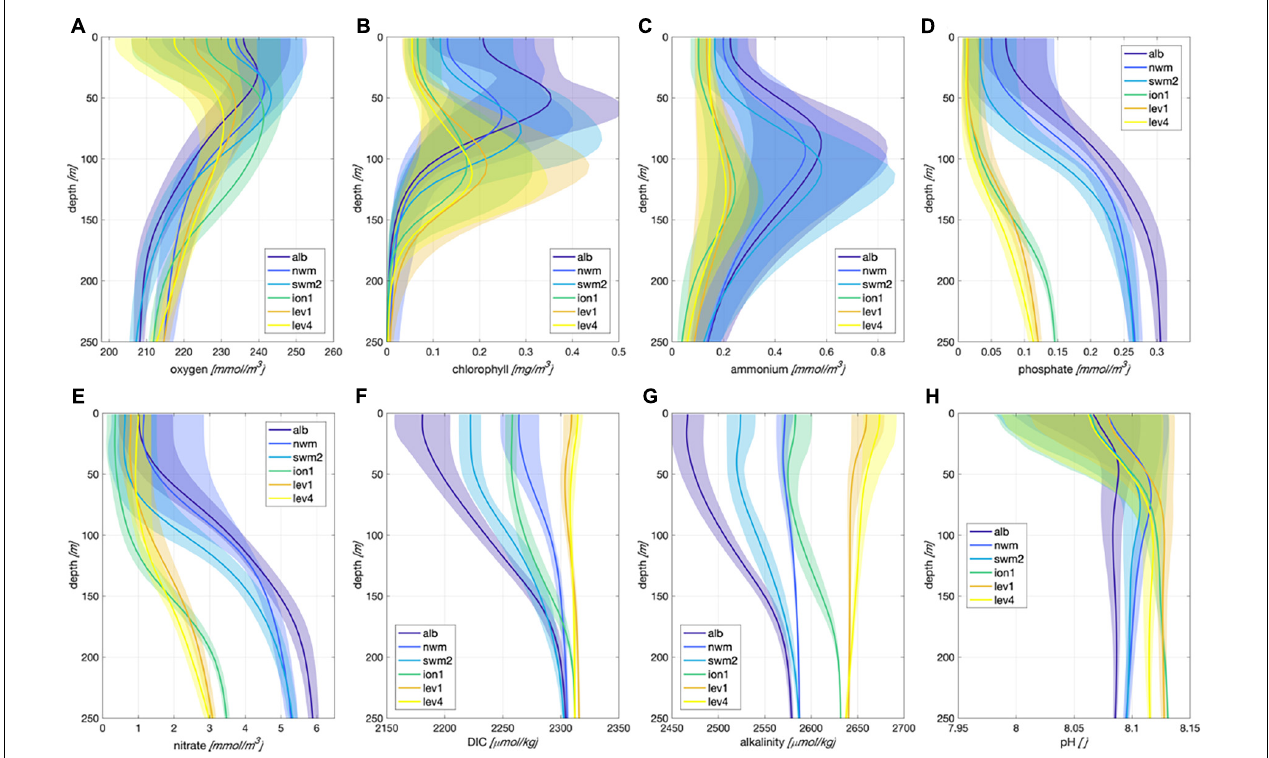
FIGURE 9 | Spatial and temporal variability for selected variables: oxygen (A) , chlorophyll (B) , ammonium (C) , phosphate (D) , nitrate (E) , DIC (F) , alkalinity (G) , pH (H) . For each variable, mean annual average profiles for sub-basins along the zonal direction (colored solid lines) and mean seasonal cycle within each sub-basin (colored shaded areas) are